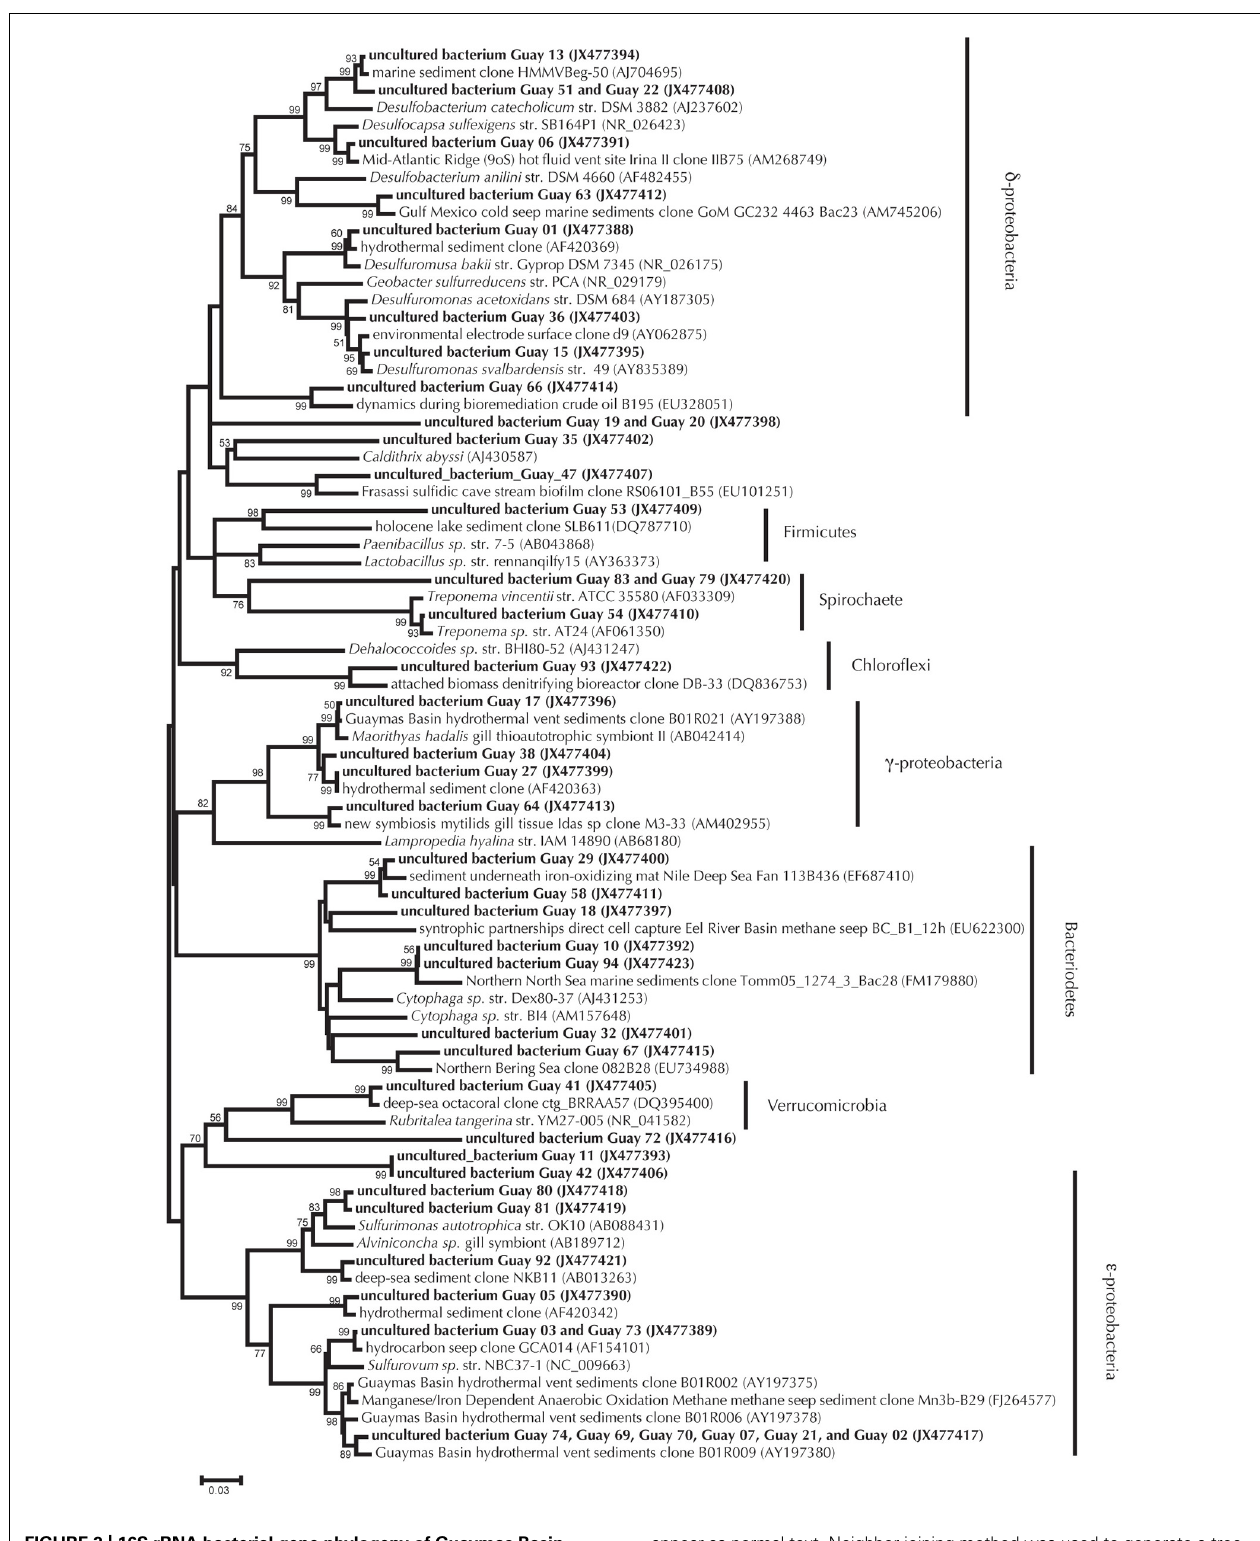
appear as normal text. Neighbor joining method was used to generate a tree with a Jukes–Cantor correction of evolutionary distance. Bootstrap values for branches occurring for > 50% of 1000 iterations are reported. Scaling of the phylogenetic tree is based on an evolutionary distance of